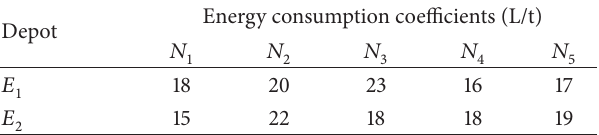
Table 2: Energy consumption coefficients from depots to distribu- tion centers.